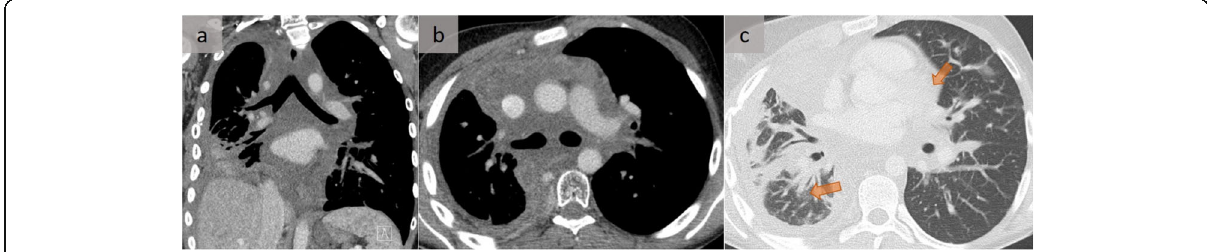
Fig. 15 Pulmonary lymphangiomatosis. A patient with diffuse pulmonary lymphangiomatosis. Such an infiltration that may not be differentiated from another diffuse, soft tissue mediastinal disease is well assessed on a coronal ( a ) and an axial ( b ) slice. Note the associated right pleural involvement ( a – c ), with thickening of the pulmonary peribronchovascular bundles and interlobular septae (arrows in c ) that reflect lymphatic